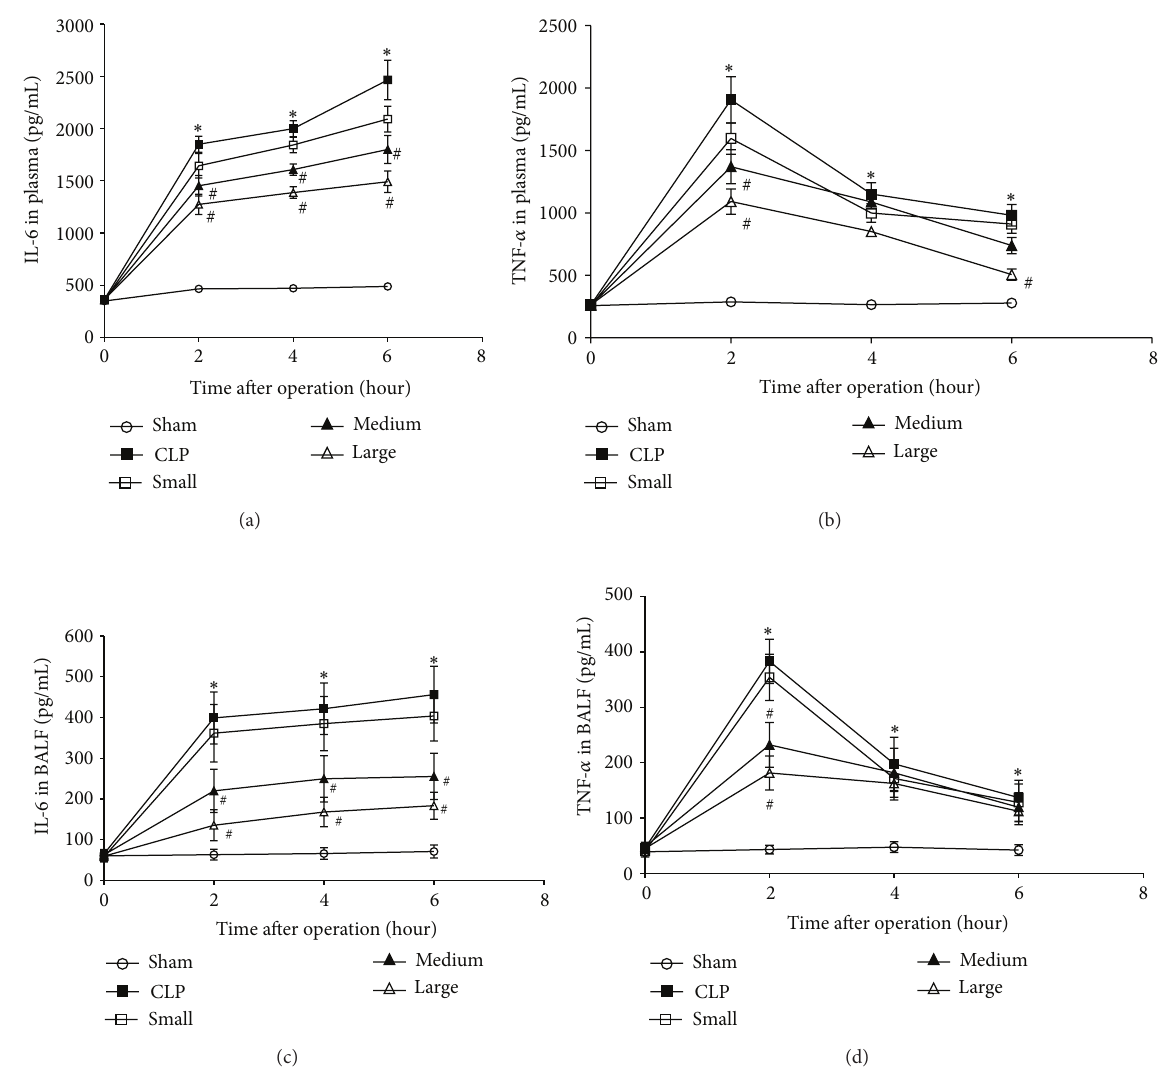
Figure 4: Levels of interleukin-6 (IL-6) and tumor necrosis factor- 𝛼 (TNF- 𝛼 ) in plasma (𝑛 = 6) and bronchoalveolar lavage fluid (BALF) (𝑛 = 8) . (a) IL-6 in plasma. (b) TNF- 𝛼 in plasma. (c) IL-6 in BALF. (d) TNF- 𝛼 in BALF. Data are expressed as mean ± SD. ∗ 𝑃 < 0.01 , versus sham group; # 𝑃 < 0.01 , versus CLP